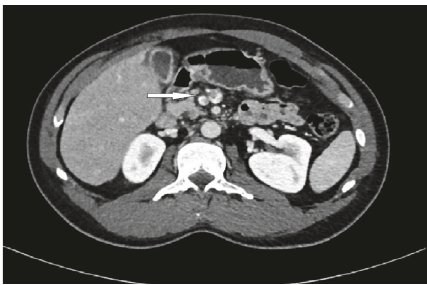
Figure 3: Contrast-enhanced CT abdomen after 6 months of anticoagulation showing complete recanalization of previously seen portomesenteric